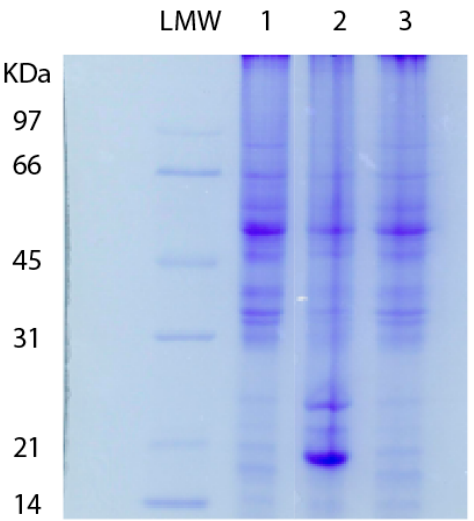
Figure 3. 10% SDS-PAGE electrophoresis of retinal lysates: control rats (lane 1), LD un-treated albino rats (lane 2) and saffron-treated albino rats (lane 3). Low molecular weight (LMW) standard proteins are reported on the left.